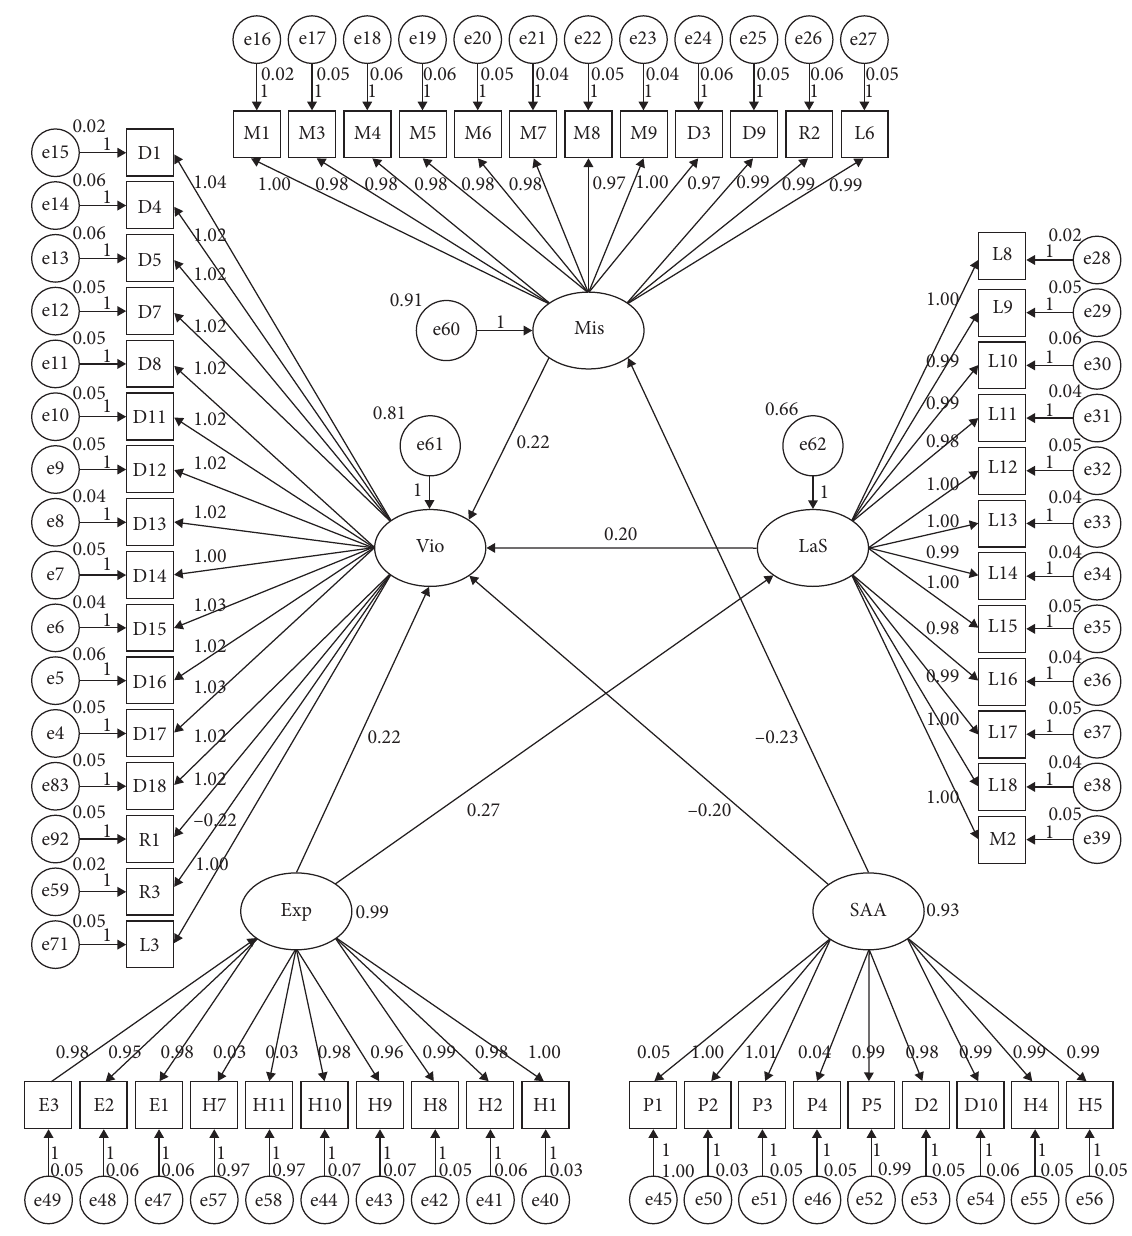
Figure 3: Results of the hypothetical structural